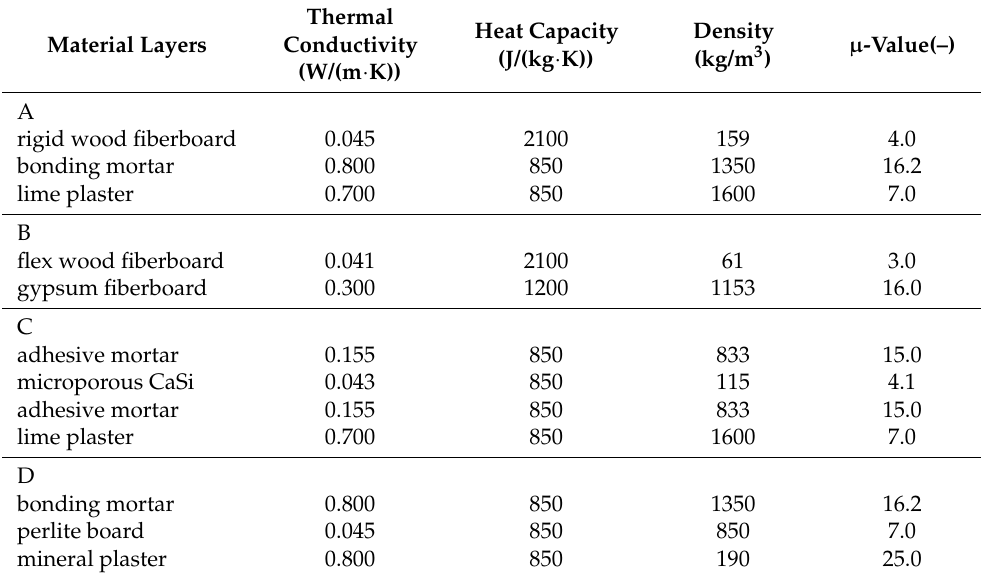
Table 2. Properties of the main internal retrofitting materials for external